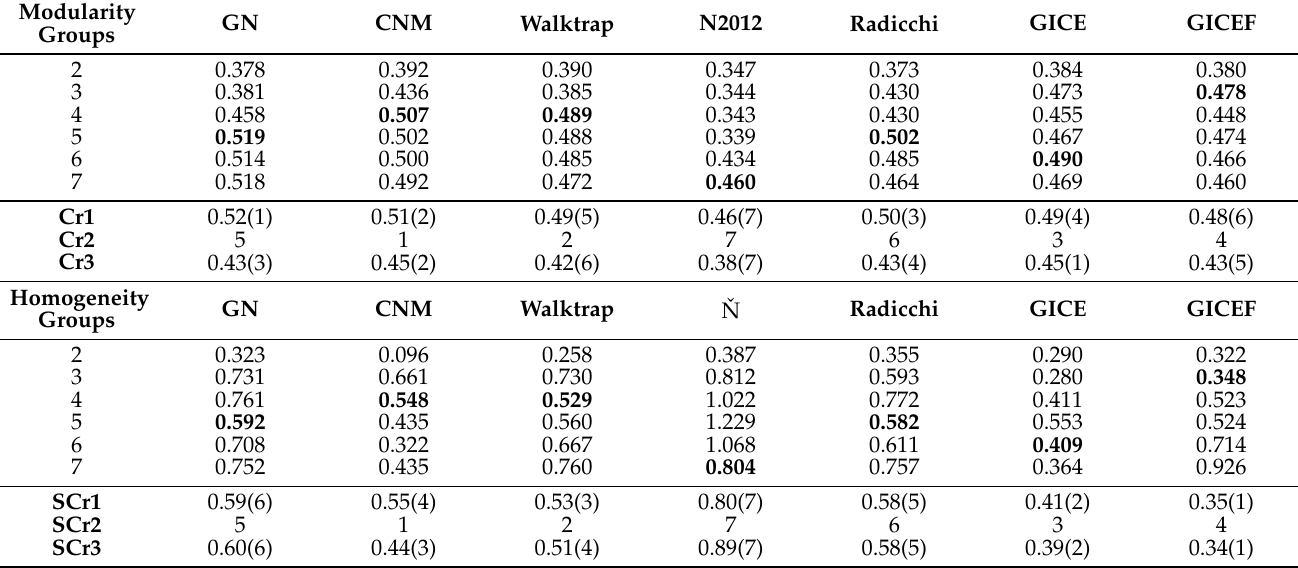
Table 3. Modularity and Homogeneity for partitions with k groups ( k = 2, . . . ,7) obtained using the GN, CNM, Walk- trap, N2012, Radicchi, our GICE and its fast version (GICEF) for the dolphins network. The criteria values are shown in parentheses.